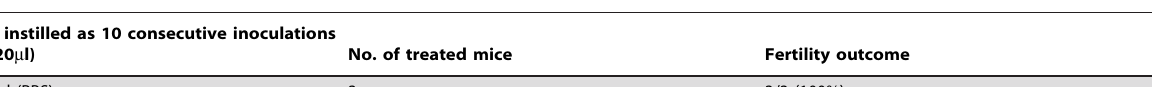
Dose instilled as 10 consecutive inoculations (cfu/20 m l) No. of treated mice Fertility outcome